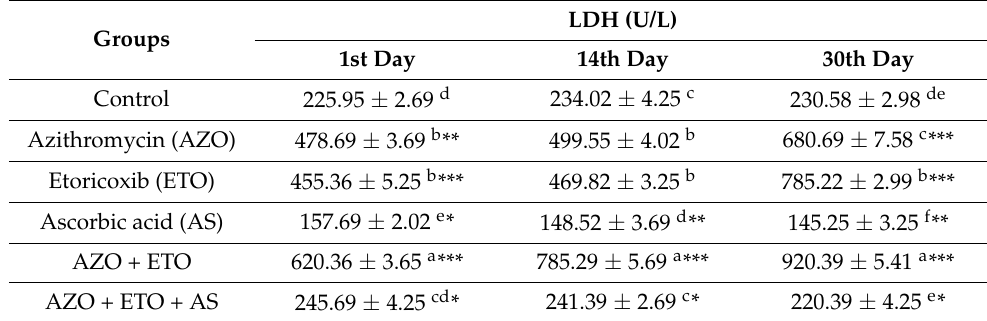
Table 3. Effects of ascorbic acid on lactate dehydrogenase enzyme (LDH) in male rats after 30 succes- sive days of administration of either azithromycin or etoricoxib or their combinations. Groups